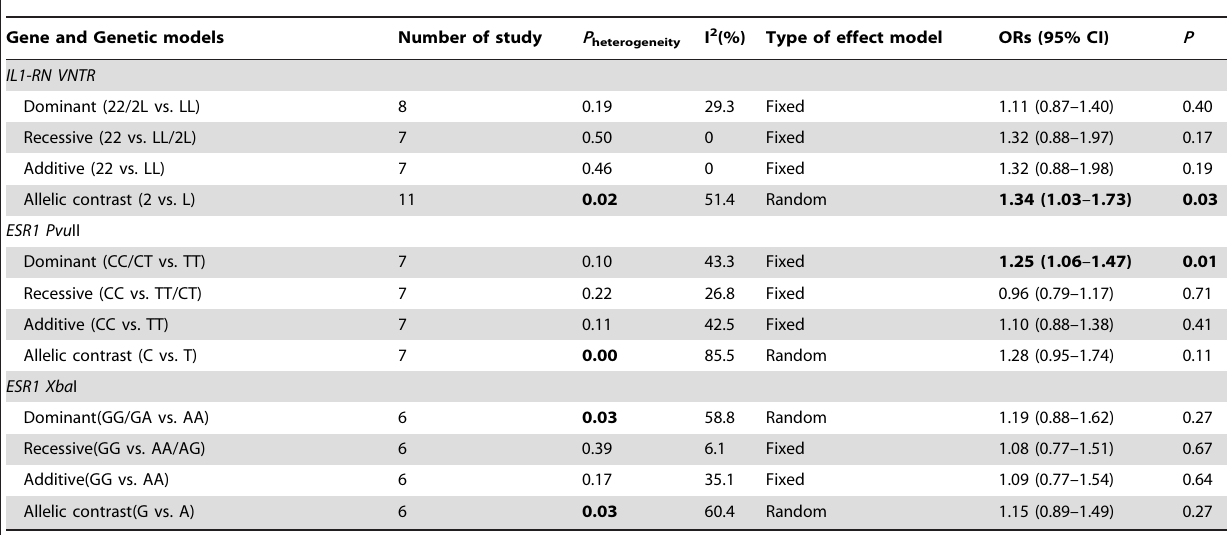
Table 4. Main results of meta-analysis of the association of IL1-RN VNTR, ESR1 Pvu II and ESR1 Xba I polymorphisms with SLE